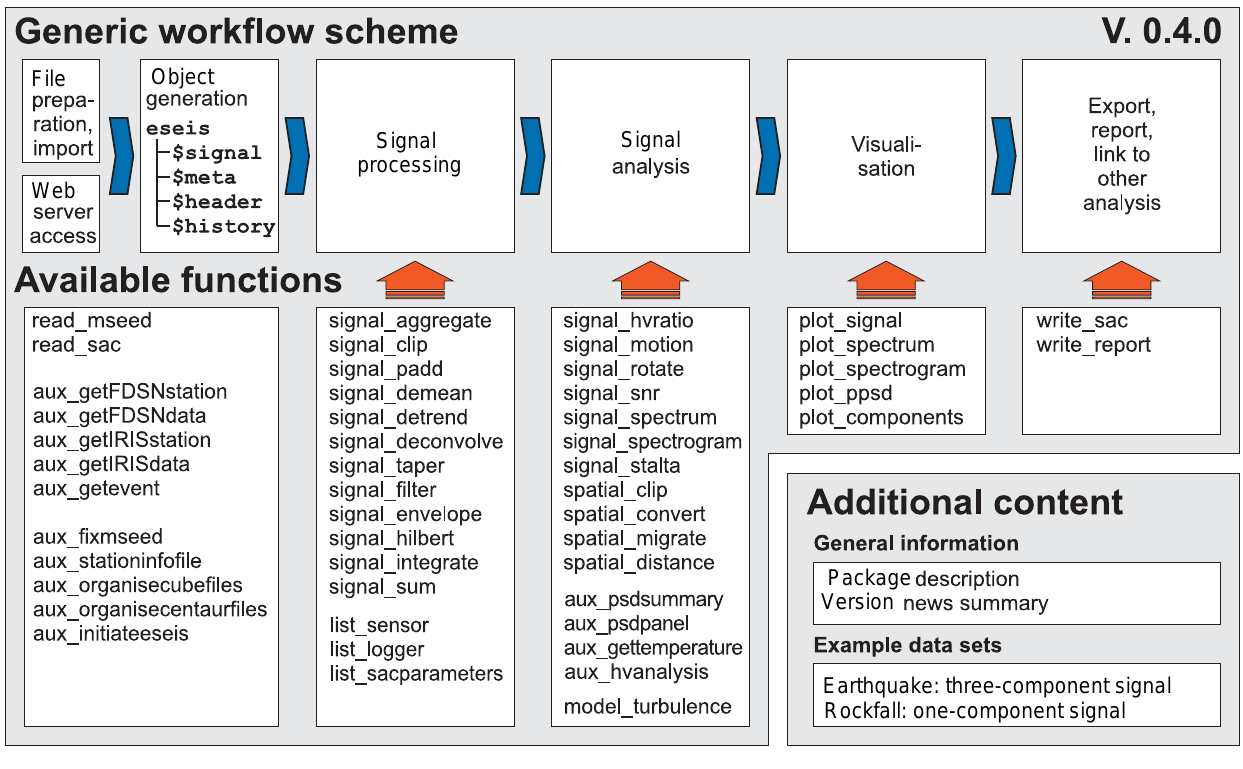
Figure 1. General work flow and available functions of the “eseis” package.